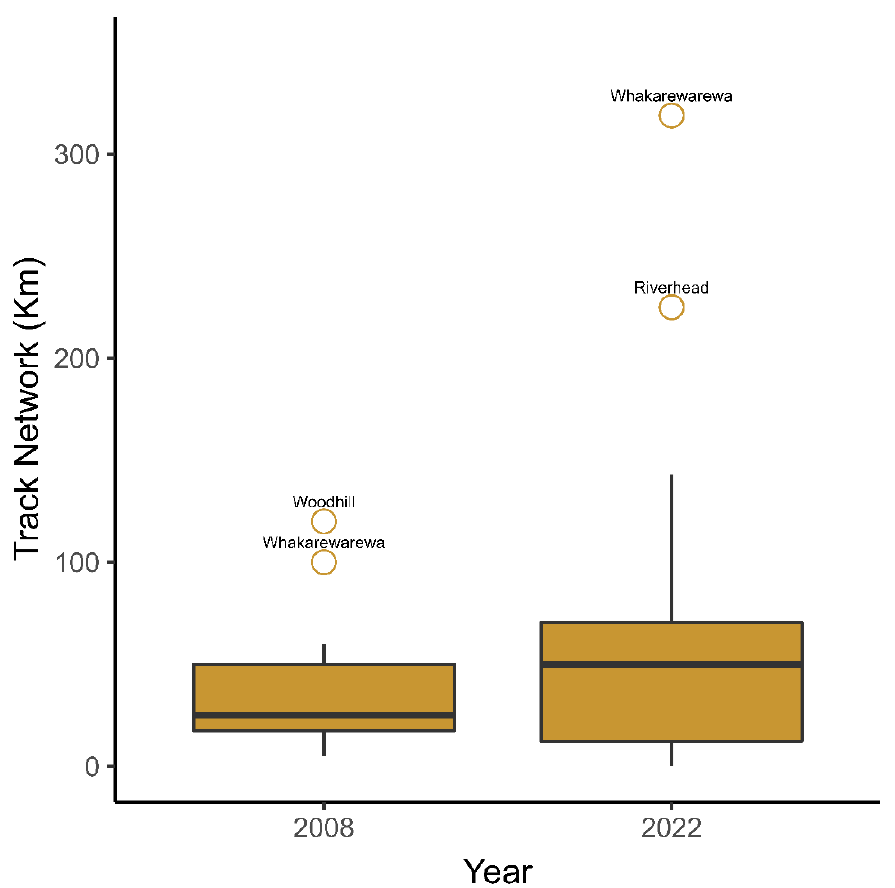
Figure 4. Boxplot showing change in mountain bike accessible track networks in production plantation forests (>1500 ha) between 2008 and 2022. The box bounds the interquartile range (IQR) divided by the median; whiskers extend to a maximum of 1.5 × IQR beyond the box. Open circles are outlier sample data points. Figure based on 23 forests with >5 km track access in 2008, resampled in 2022.